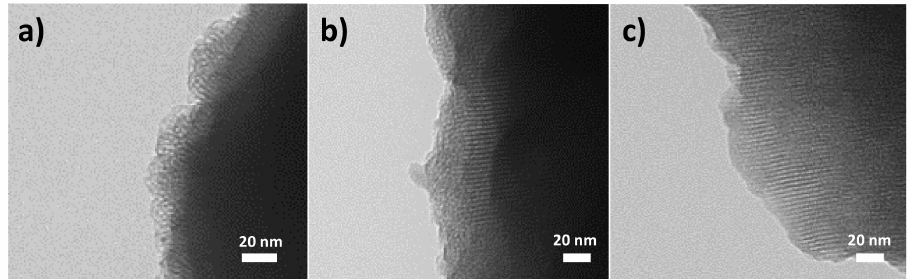
Figure 2. Representative TEM images of ( a ) calcined MCM-41 parent solid, ( b ) MCM-Met-N3 solid, and ( c ) MCM-Saf-N3 solid.